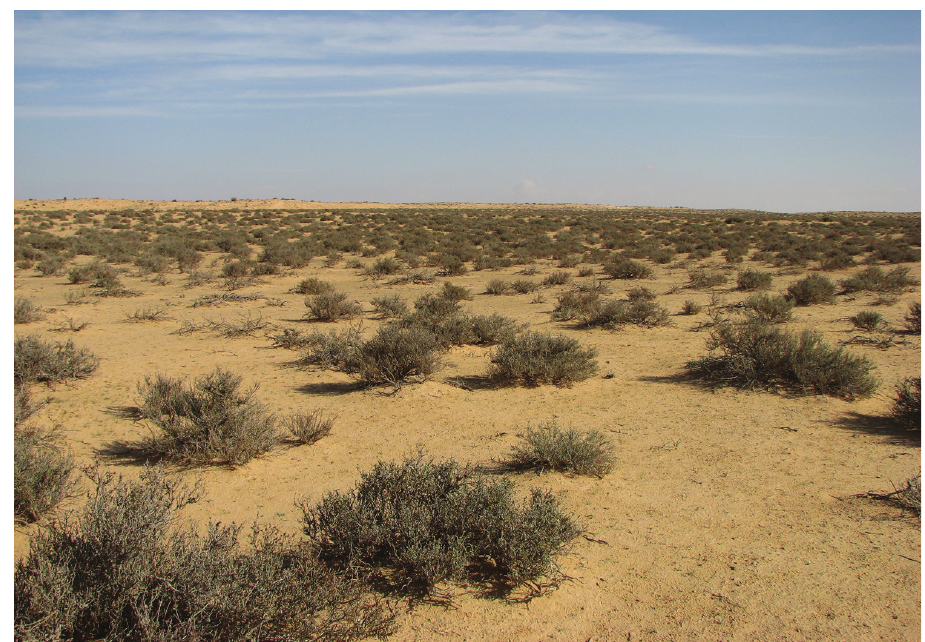
Figure 12. Habitat of Graphipterus multiguttatus : Sand rich with loess soil, relatively rich in annual plants. Western Negev sands,